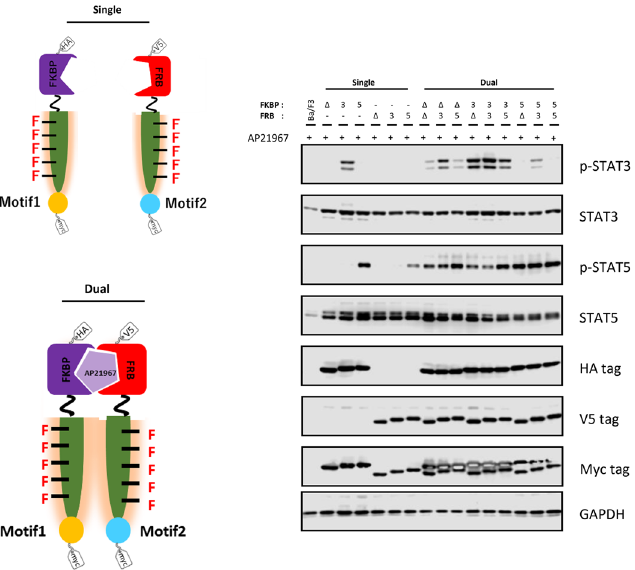
Figure 2. Comparison of the single transductants and double transductants of the FKBP and FRB chimeras. The symbols Δ, 3, and 5 mean no motif, the STAT3-binding motif, and the STAT5-binding motif, respectively. Parental Ba/F3 and the transduced cells were unstimulated (−) or stimulated with 50 nM AP21967 (+). Phospho-STAT3, whole STAT3, phospho-STAT5, whole STAT5, HA tag (FKBP chimera), V5 tag (FRB chimera), Myc tag (both FKBP and FRB chimeras; upper and lower bands, respectively), and GAPDH (loading control) were detected using corresponding primary antibodies. Full-length blots are presented in Supplementary Fig.